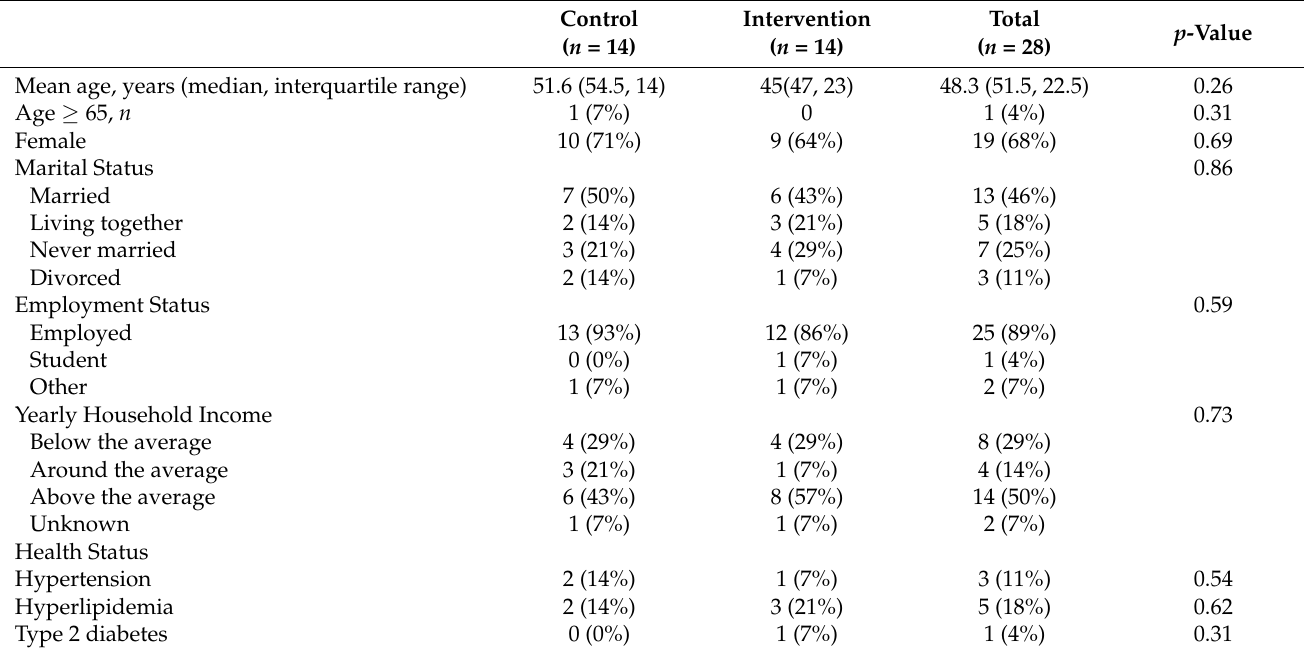
Table 1. Demographics of participants in the culinary coaching